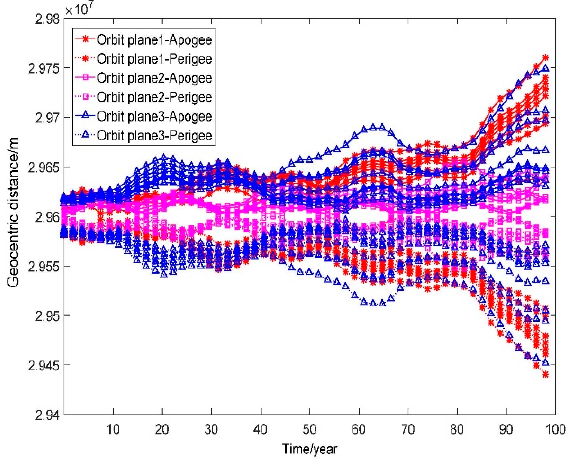
Figure 6. Orbital variations of BDS satellites over 100 years.